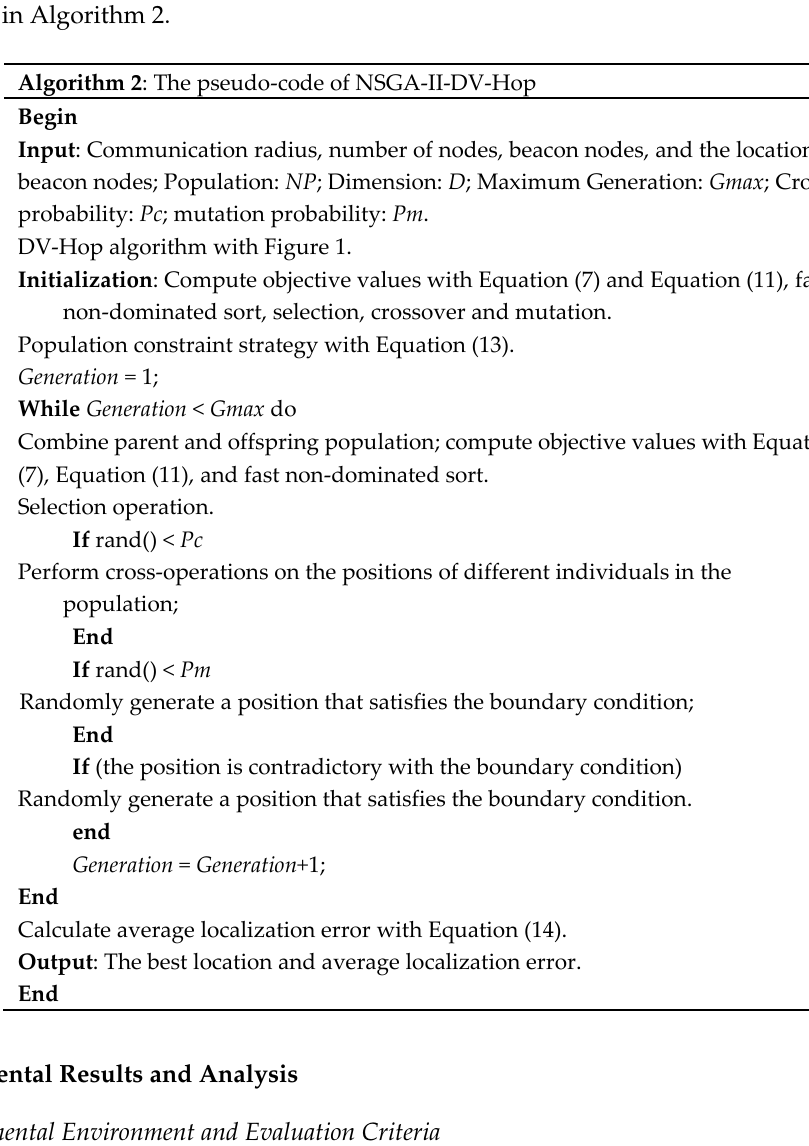
Figure 6. Population constraint strategy. ( a ) Population constraint based on three beacon nodes; ( b ) Population constraint based on all beacon nodes.